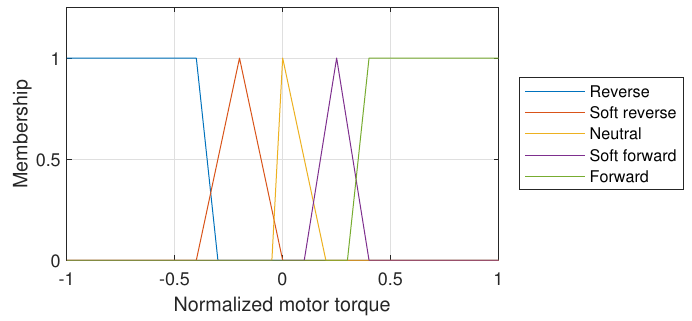
Figure 6. Red light fuzzy sets.